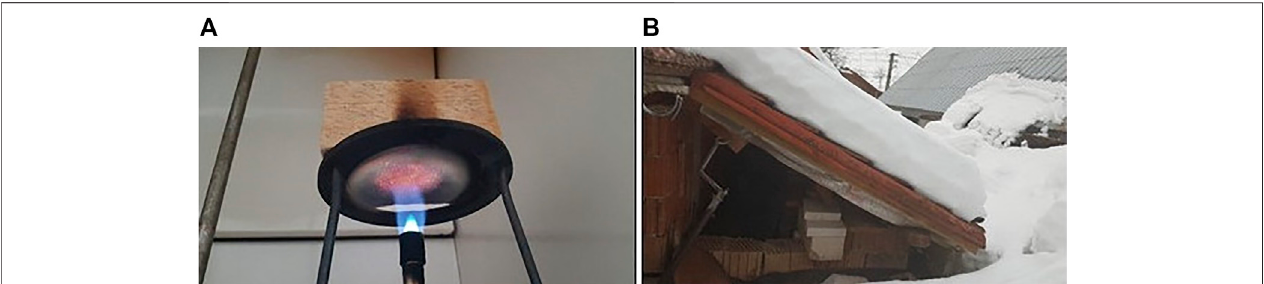
FIGURE 2 | (A) Fiberboard specimen exposed to propane-butane torch; (B) Natural aging simulation site.